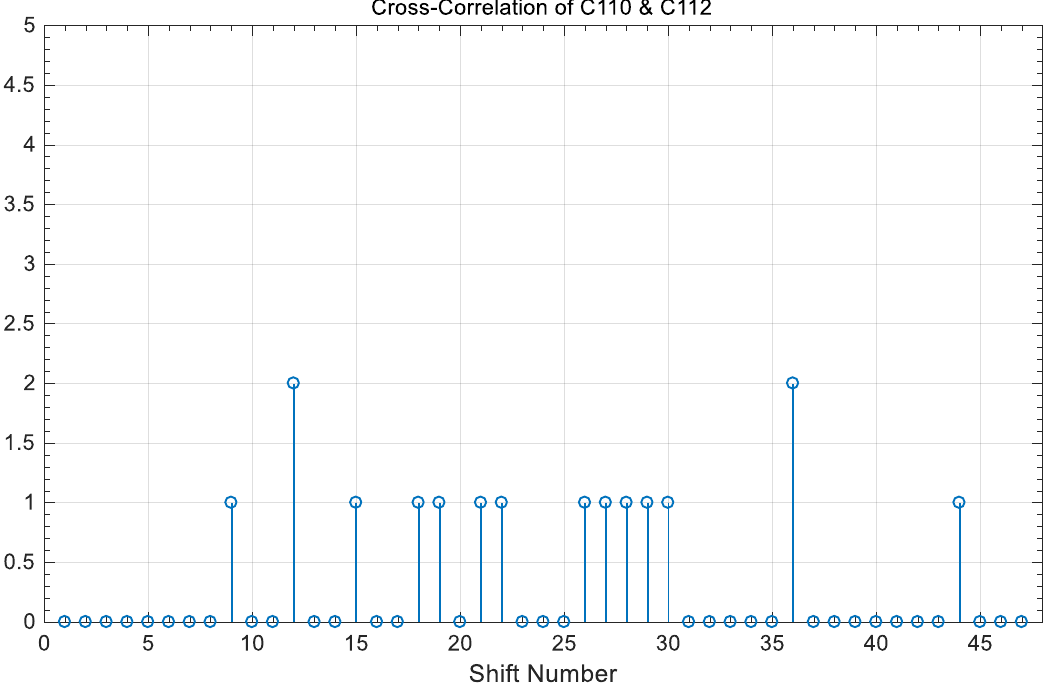
Figure 11. Cross-correlation between 𝐶 110 and 𝐶 112 sequences in same group, 𝑃 1 = 5 and 𝑃 2 = 7.